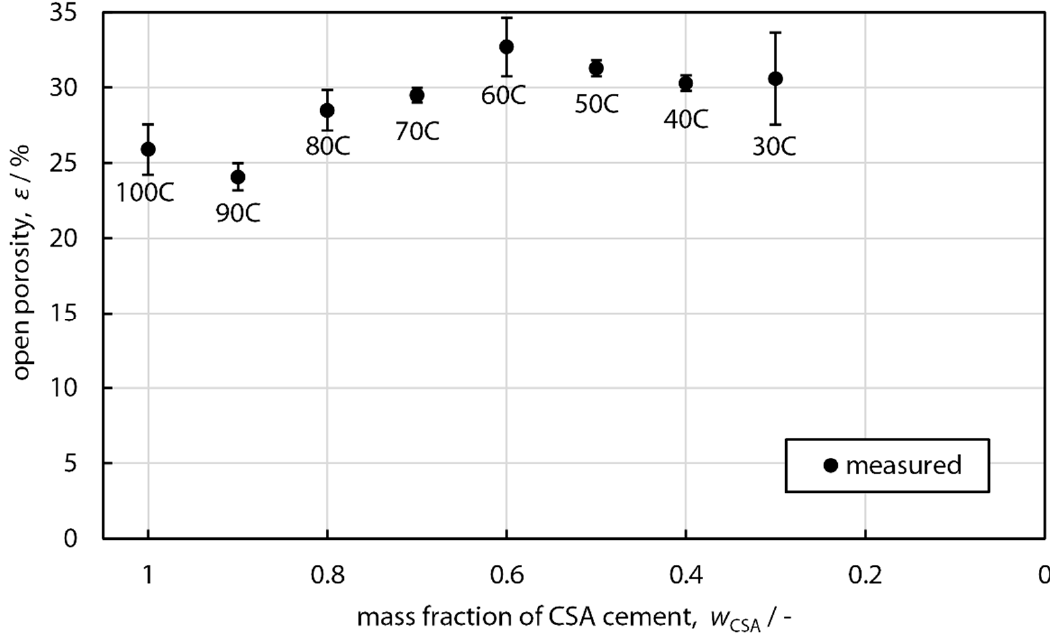
Figure 2. Open porosity measured using the Archimedes method for each sample composition using three specimens each ( N = 3). The specimens were investigated after 14 days of hydration. Table 3. Calculated volume fractions, φ i , of CSA cement, HGMSs, and air as well as the calculated density of the hydrated and dried specimens according to open